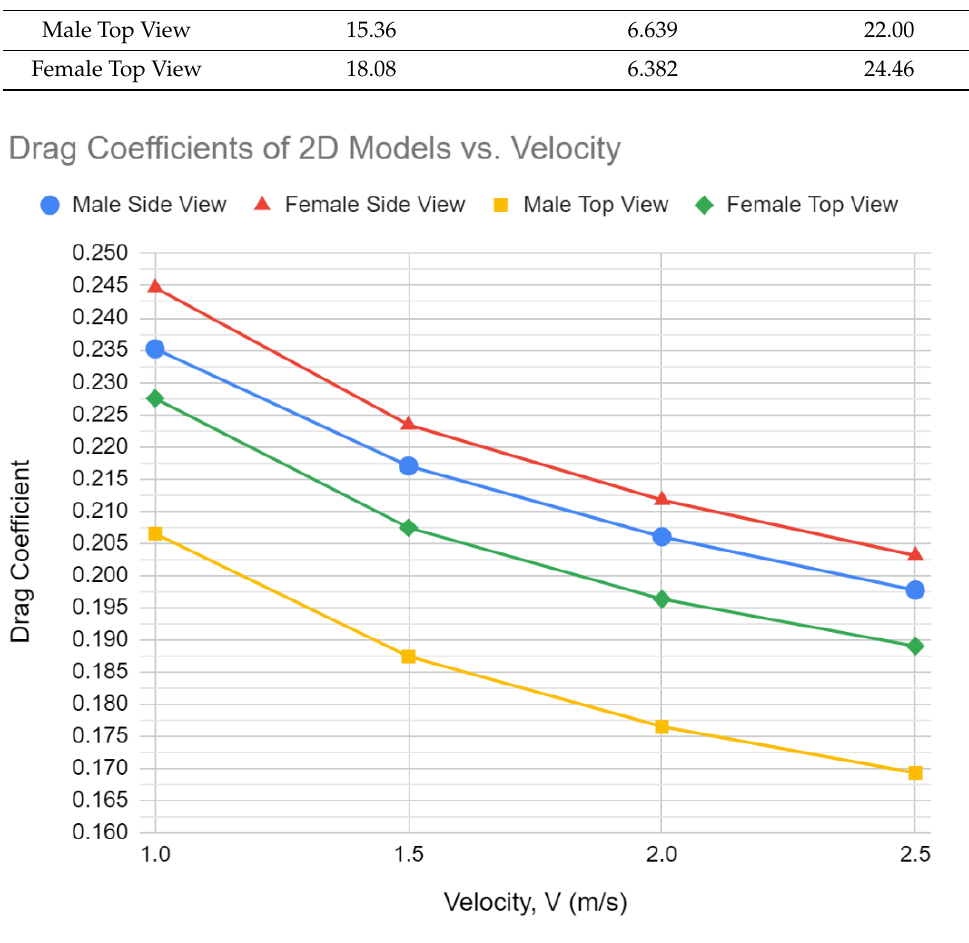
Figure 9. Graph of Drag Coefficients of 2D Models vs. Velocity (obtained from the drag force via. Equation (5)).